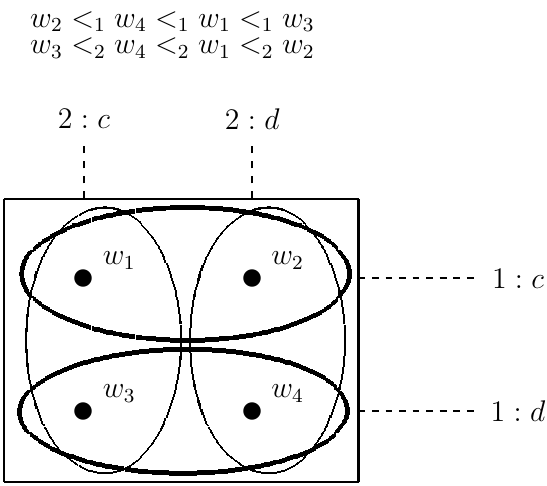
Figure 1. The equivalence class { w game [15] between two players 1 and 2 (action c stands for ‘cooperate’ and action d stands for ‘defect’). Thick ellipses are epistemic relations for 1 , thin ellipses are epistemic relations for 2 (both 1 and 2 are uncertain about the other’s